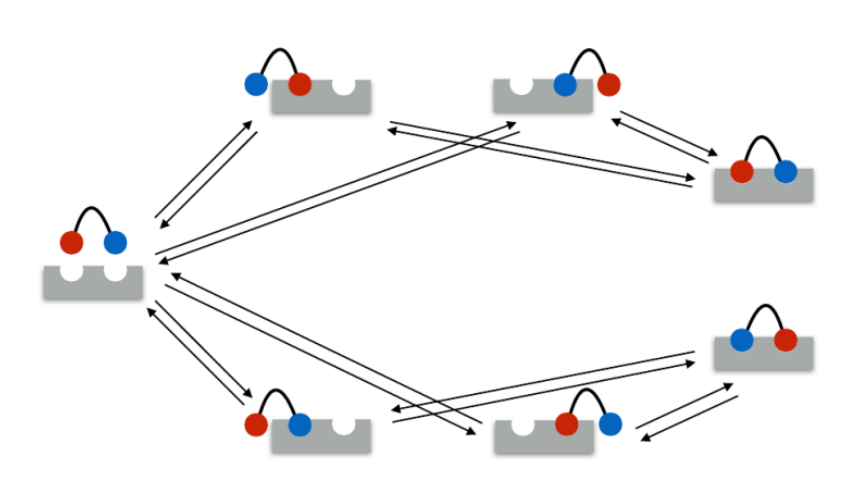
Figure 1. Bivalent bindings have seven possible states. The ligand binding sites are equal. The red and blue color refer to the possible binding permutations.